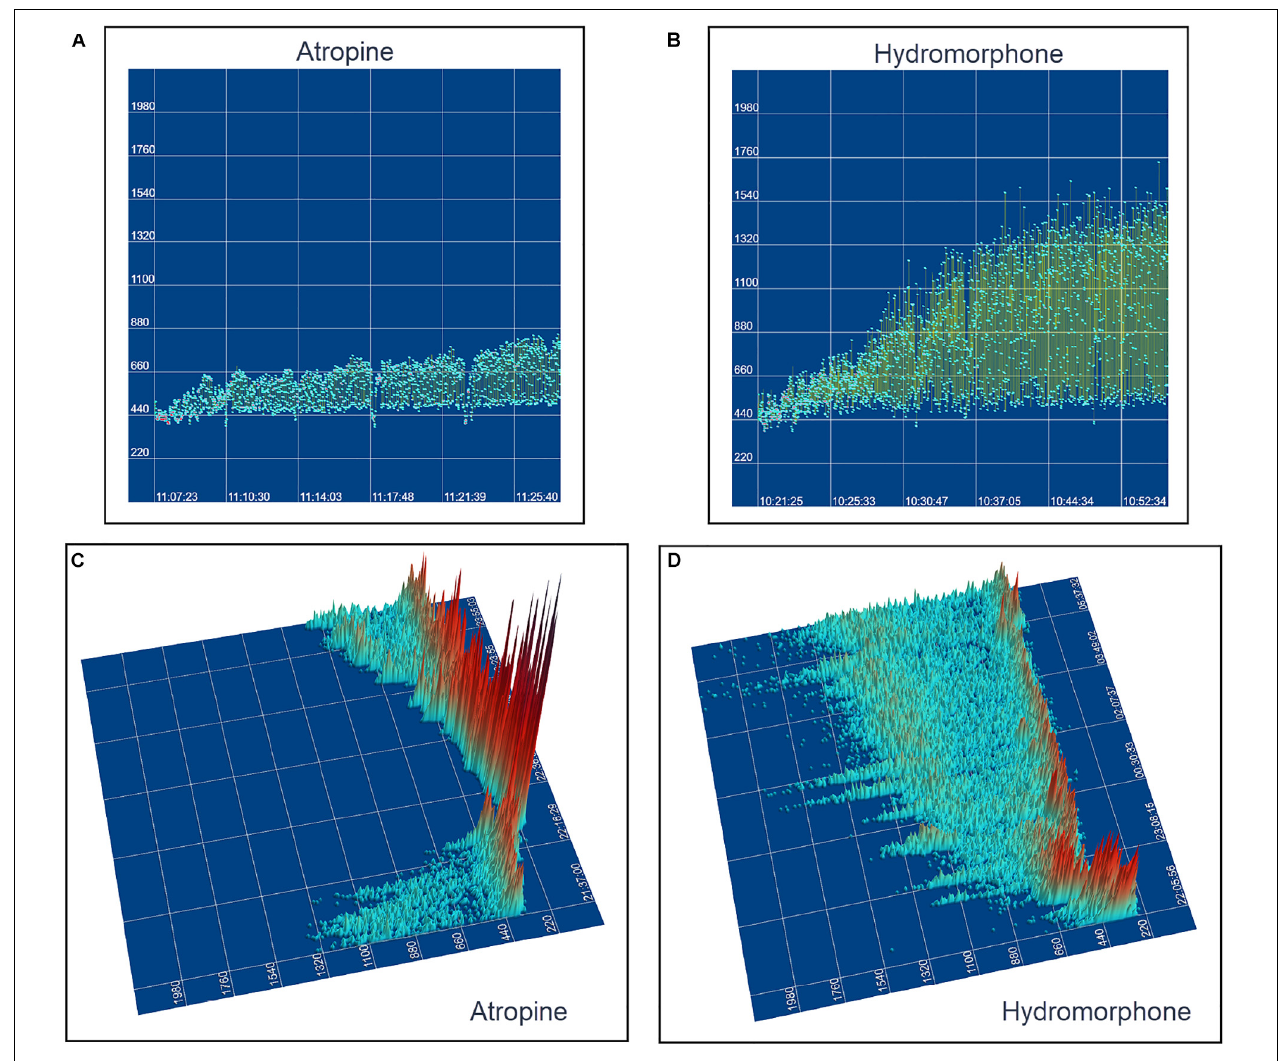
FIGURE 14 | This figure uses two-dimensional (A,B) and three-dimensional (C,D) tachograms to show the pattern and density of sinus intervals before, during, and after treatment to decrease and increase parasympathetic modulation. Recordings were from two different days for each treatment. Frame (A) (beagle 1) illustrates the interval changes (turquoise dots represent interval duration and yellow lines connect sequential intervals) as the drug effects of atropine (0.04 mg/kg given intravenously) dissipate. The decreasing and increasing interval duration associated with the increasing and decreasing drug effects of atropine are seen in frame (C) (beagle 1). As the effects of atropine subside the bifurcation interval increases with an increased paucity of beats as sinus arrhythmia returns. Frame (B,D) (beagle 8) show increasing interval duration associated with the increasing drug effects of hydromorphone (0.2 mg/kg given intravenously). The effects of hydromorphone result in an increased paucity of beats, an increase in the bifurcation interval and a greater spread of long intervals. Scaling for frames (C,D) are equal to show proportionality of the interval